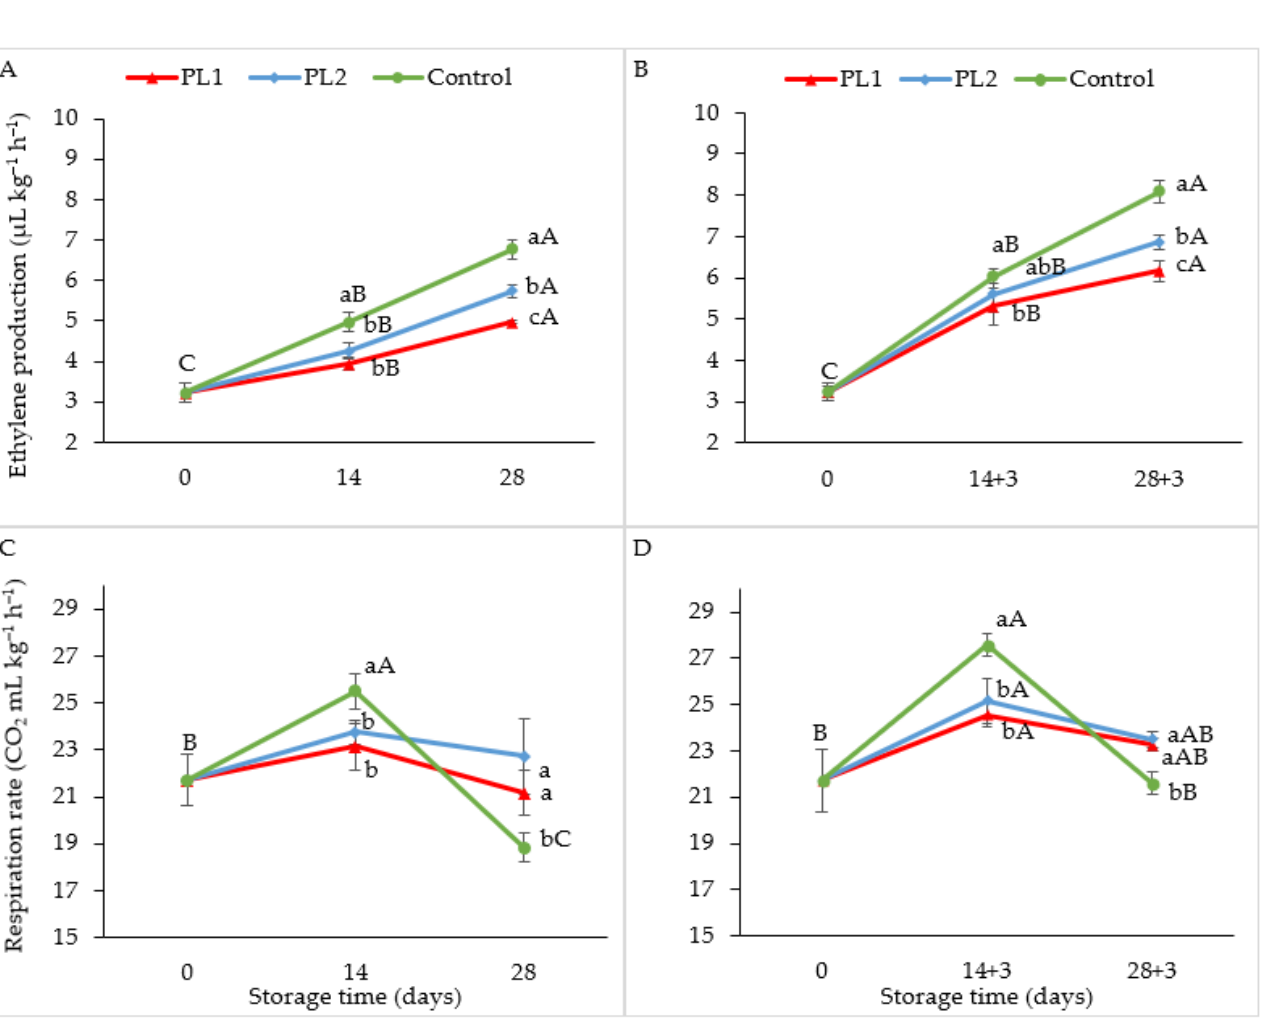
Figure 3. Ethylene production and respiration rate changes during cold storage ( A , C ), and ethylene production and respiration rate changes during shelf life ( B , D ). Data are the mean ± SE of three replicates of twenty-two fruit. Different uppercase letters indicate significant differences for each atmosphere composition during storage, and different lowercase letters indicate significant differences among atmosphere compositions for each sampling date at p < 0.05. Non-significant differences ( p ≥ 0.05) in atmosphere composition and storage time did not give any letters.